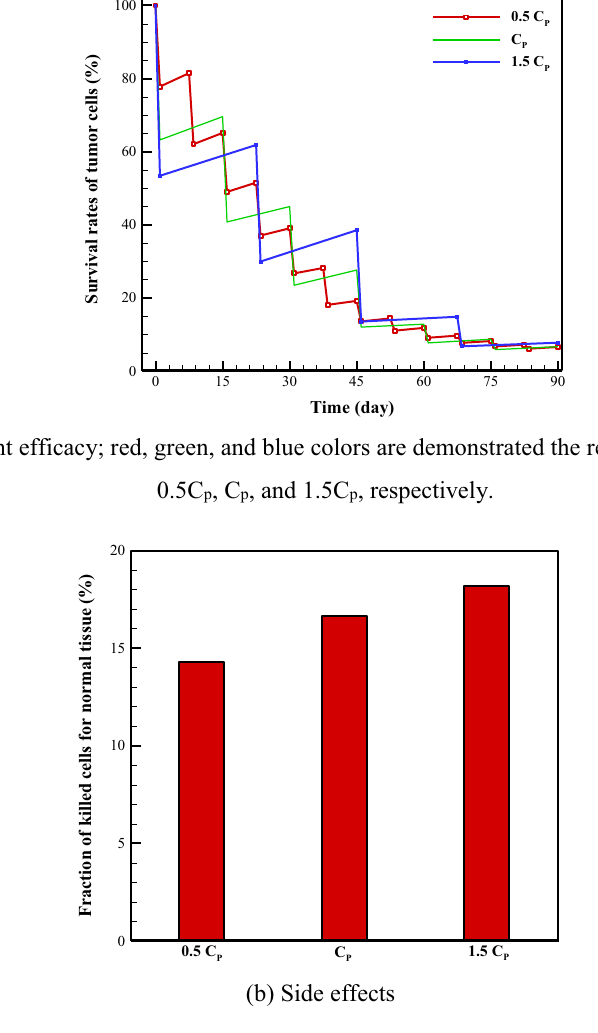
Figure 3. Survival rate of tumor cells and also side effects after 90 days for three different treatment scenarios to examine dose effect. These treatment plans are as: (i) injected dose = 0.5 C p , number of treatments = 12, and interval between treatments = 0.25-month; (ii) injected dose = C p , number of treatments = 6, and interval between treatments = 0.5-month; and (iii) injected dose = 1.5 C p , number of treatments = 4, and interval between treatments =